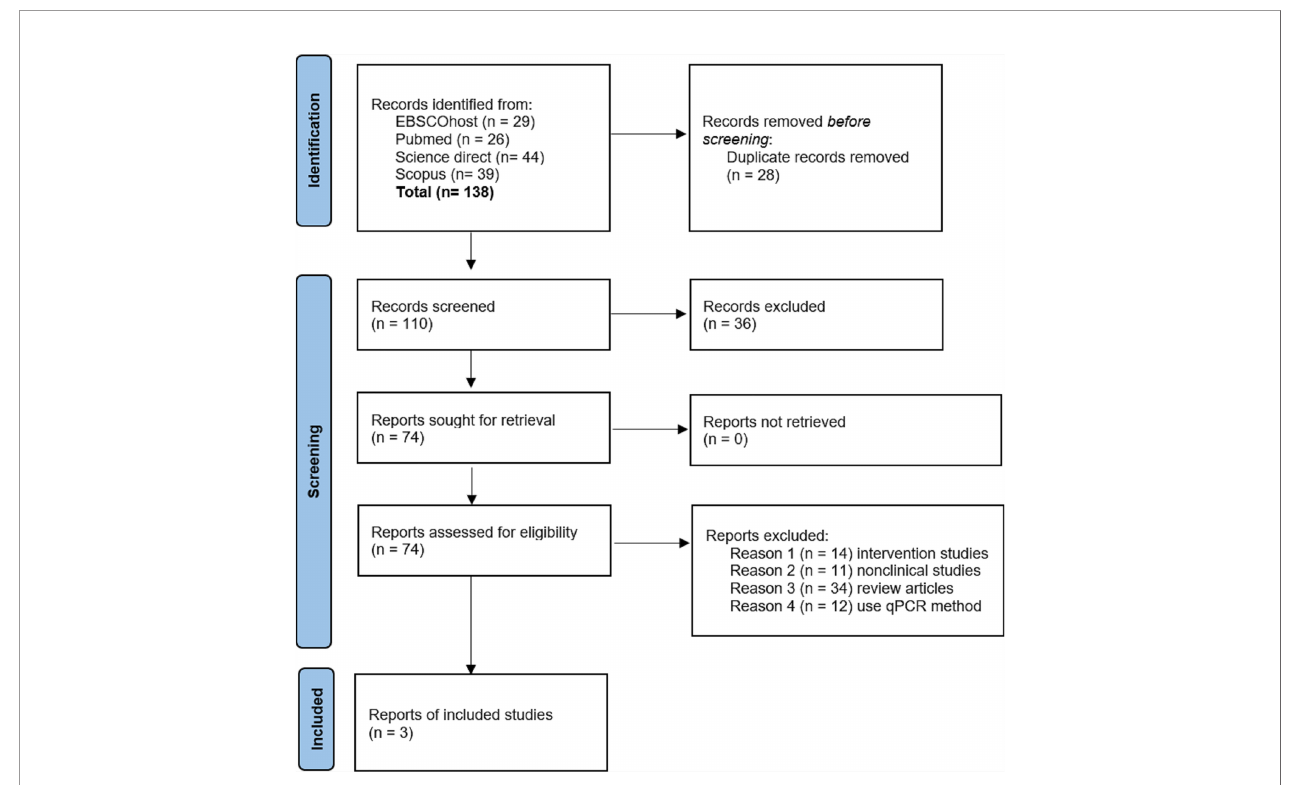
FIGURE 1 | PRISMA fl ow diagram for studies selection in this systematic